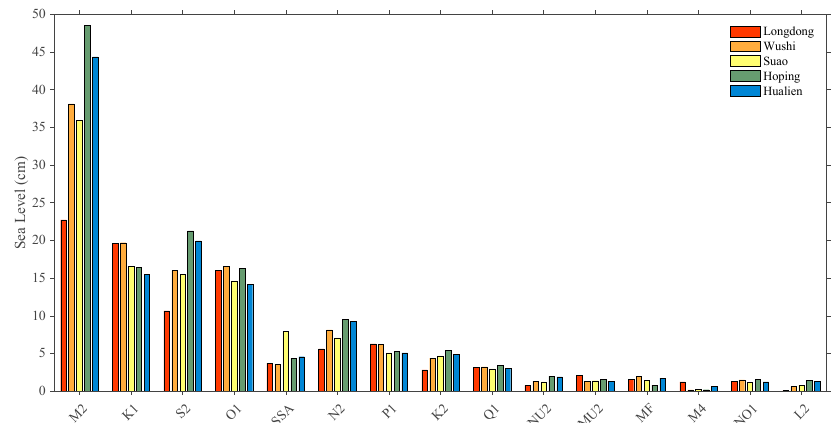
Figure 12. Amplitudes of sea level height (in cm) based on instrument reference level (RL) for 15 constituents from five tide-gauge stations from north to south in sequence.